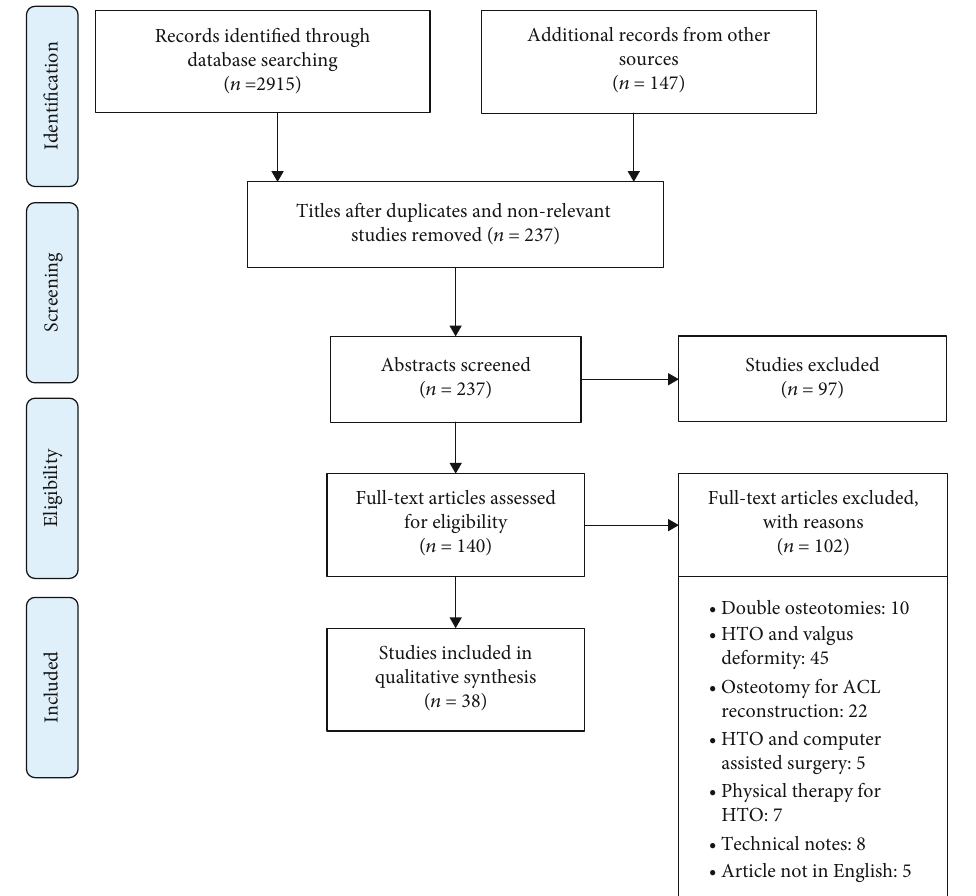
Figure 1: PRISMA fl ow diagram of the search and selection process and the e ff ect of application of inclusion/exclusion